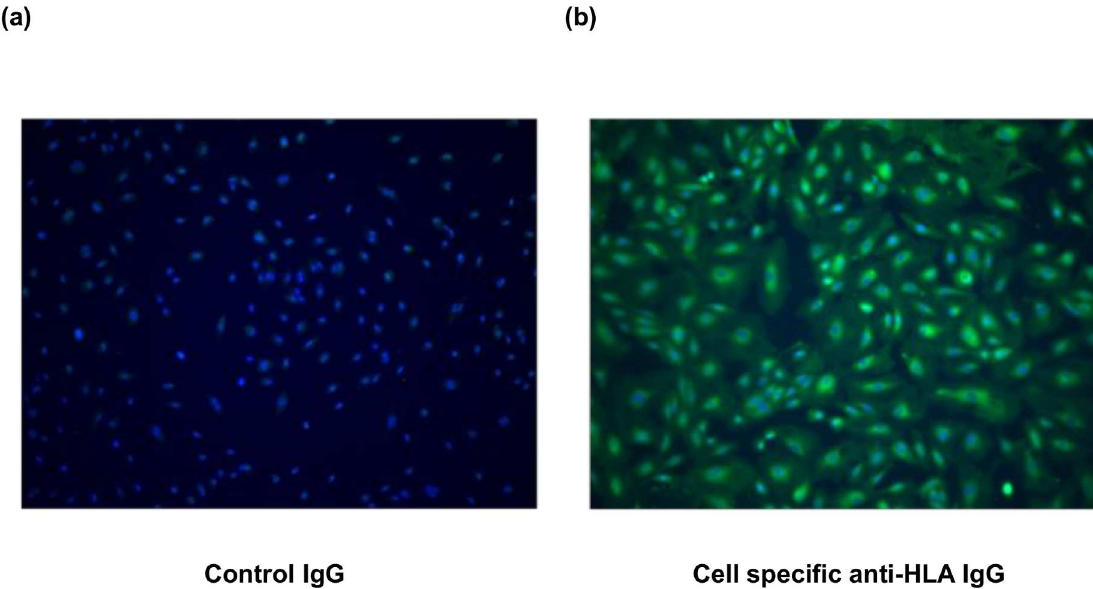
Fig 3. PurifiedIgG was specifically ligatedto humanaorticendothelial cellsin immunofluorescenceanalysis. (a) Human aorticendothelial cells (HAEC)were culturedwithin the controlIgG.Nonspecific IgG is not ligatedto the HAEC. (b) HAEC were incubated withina specific anti-HLAIgG.PurifiedIgG is specificallyligatedto the HAEC. Pseudo-green: anti-human IgG, pseudo-blue: DAPI.